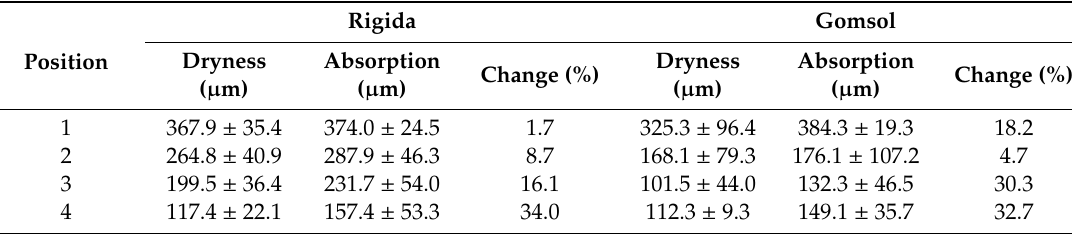
Table 2. Changes in thickness of the cone scale based on dryness and absorption status.